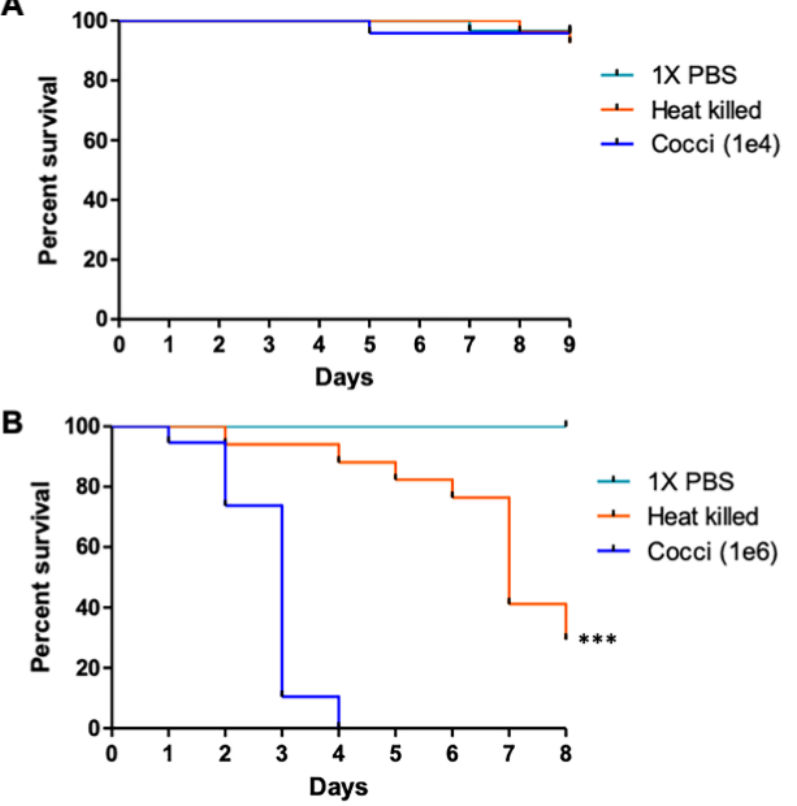
Figure 1. The C. posadasii S/E strain is virulent in an insect model of infection . Larva of Galleria mellonella inoculated with 10 4 spherules were not affected ( A ), whereas inoculation of 10 6 spherules resulted in 100% death of larvae within 4 days ( B ). Heat-inactivation of the C. posadasii strain prior to inoculation improved survival significantly. PBS controls show no difference in survival. Statis- tical analysis was performed using GraphPad Prism software by estimating differences in survival (log rank and Wilcoxon tests) using the Kaplan–Meier method (*** p = 0.0001). Shown is one of three replicates.